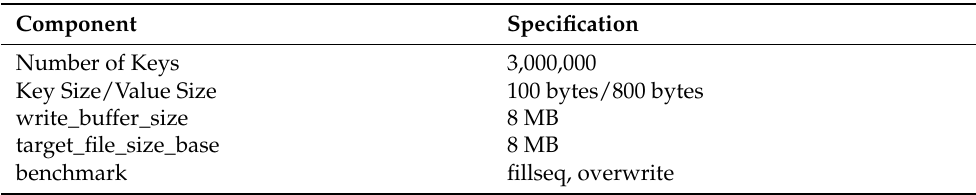
Table 3. db_bench Workload